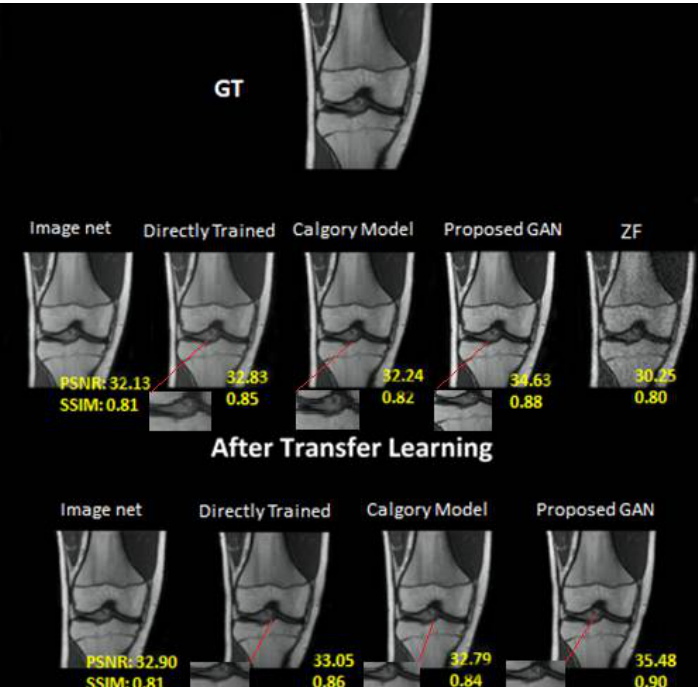
Figure 9. At AF = 2, Reconstruction results on knee dataset. From left to right: (i) Image Net; (ii) Directly trained; (iii) Calgary Model; (iv) Proposed GAN; (v) ZF. In the second row: (i) Image net; (ii) Directly Trained; (iii) Calgary Model; (iv) Proposed GAN results of same slices from knee image dataset after applying transfer learning.